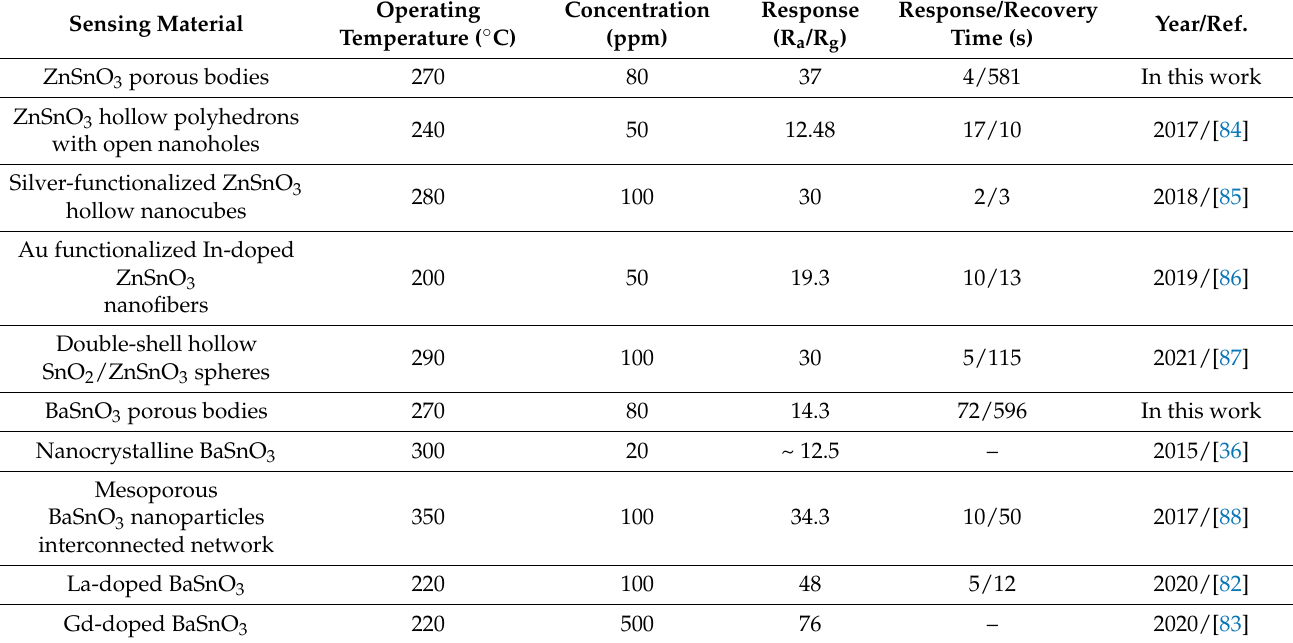
Table 2. Comparative table summarizing the results of this work and the sensing properties of various ZnSnO 3 and BaSnO 3 based sensors reported in the literature towards acetone and ethanol,